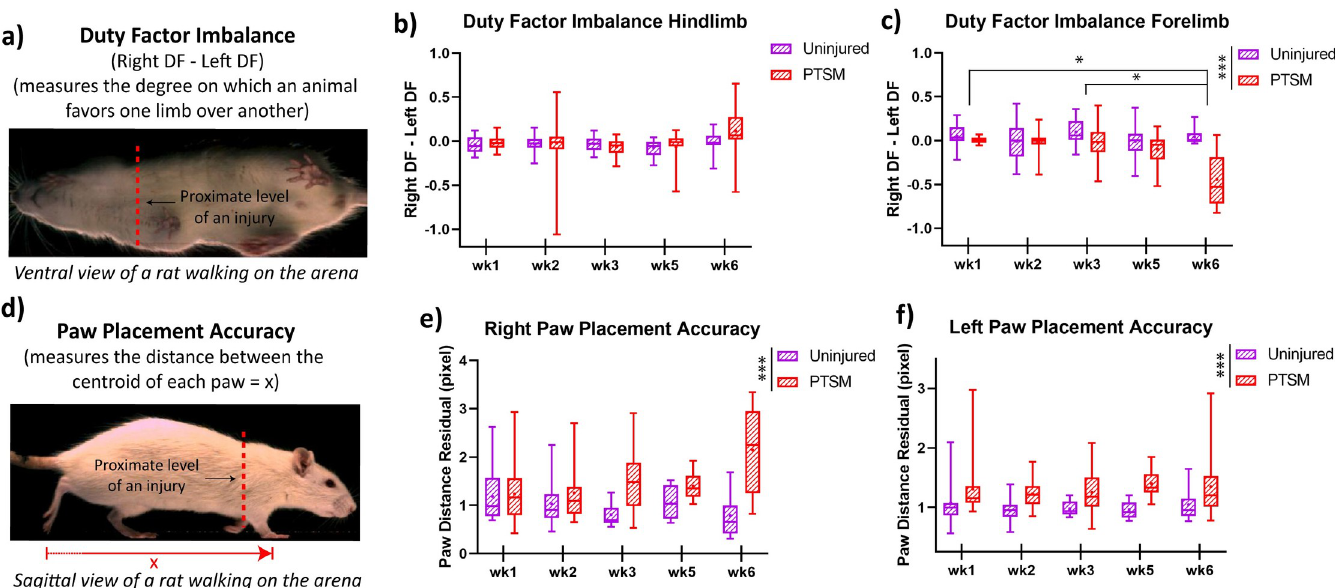
Fig 4. PTSM injury affects duty factor imbalance of the forelimb and paw placement accuracy of both right and left paws. a) A visual definition of duty factor imbalance. b) Hindlimb duty factor imbalance is unaffected by the syrinxes present in the spinal cord due to PTSM injury, whereas c) forelimb duty factor imbalance got affected by the injury model. d) A definition of paw placement accuracy is presented pictorially. Syrinxes present in the spinal cord due to injury greatly affected the right (e) as well as left (f) paw placement accuracy. However, there is no significant difference at the different time points from week 1 to week 6. For all graphs, data are presented as mean ± standard error. For the uninjured group n = 6, and PTSM group n = 9, for both groups subsamples (videos) s = 4 to 6. � denotes p < 0.05, �� denotes p < 0.01, ��� denotes p < 0.005, ���� denotes p < 0.001 represents statistical significance as determined by the mixed-effect model with Tukey’s post hoc ( p < 0.05).